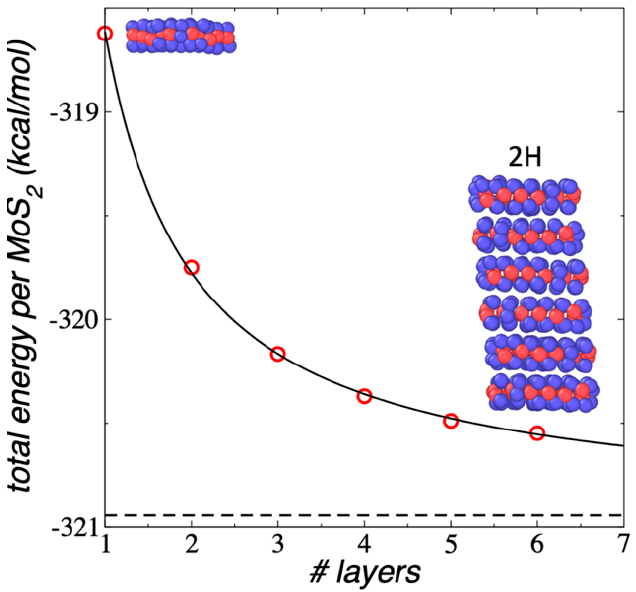
Figure 9. E #MoS2 of 1L, 2L, and ML Mo 27 S 54 flakes (red circles) as a function of the number of MoS 2 units, under vacuum and NVT conditions at 298.15 K. The black line represents a fitting to an exponential decay expression with the discontinuous black line represent the plateau value. The inset snapshots correspond to the equilibrated conformations of the 1L (1–Mo 27 S 54 ) and ML (6–Mo 27 S 54 ) flakes. Blue and red spheres represent Mo and S atoms, respectively.